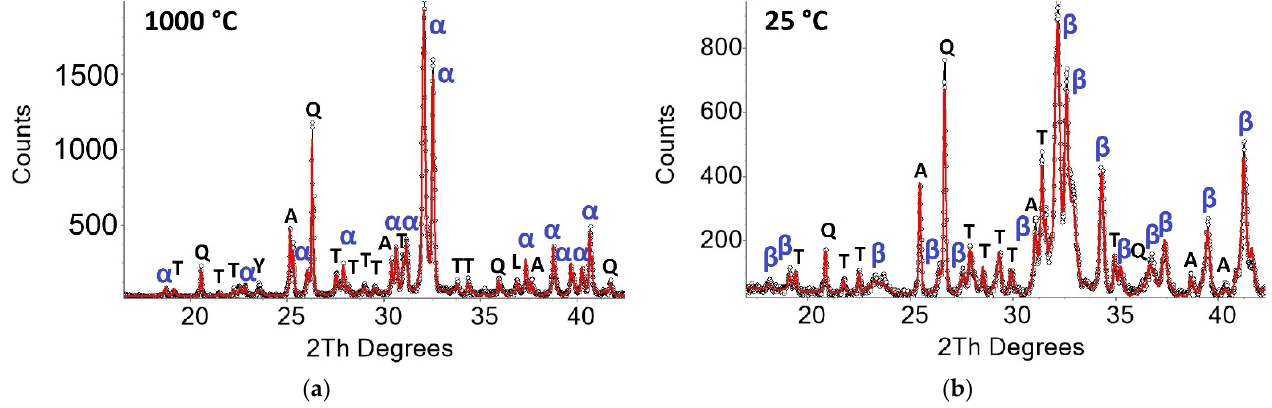
Figure 1. Powder pattern of Sample D3 at 1000 °C ( a ) and 25 °C after the heating experiment in steps of 50 °C ( b ). Peaks of the main phases are marked as α - α ’H-C 2 S, β - β -C 2 S, A-anhydrite, Q-quartz, T-ternesite, L-lime, Y-ye’elimite.